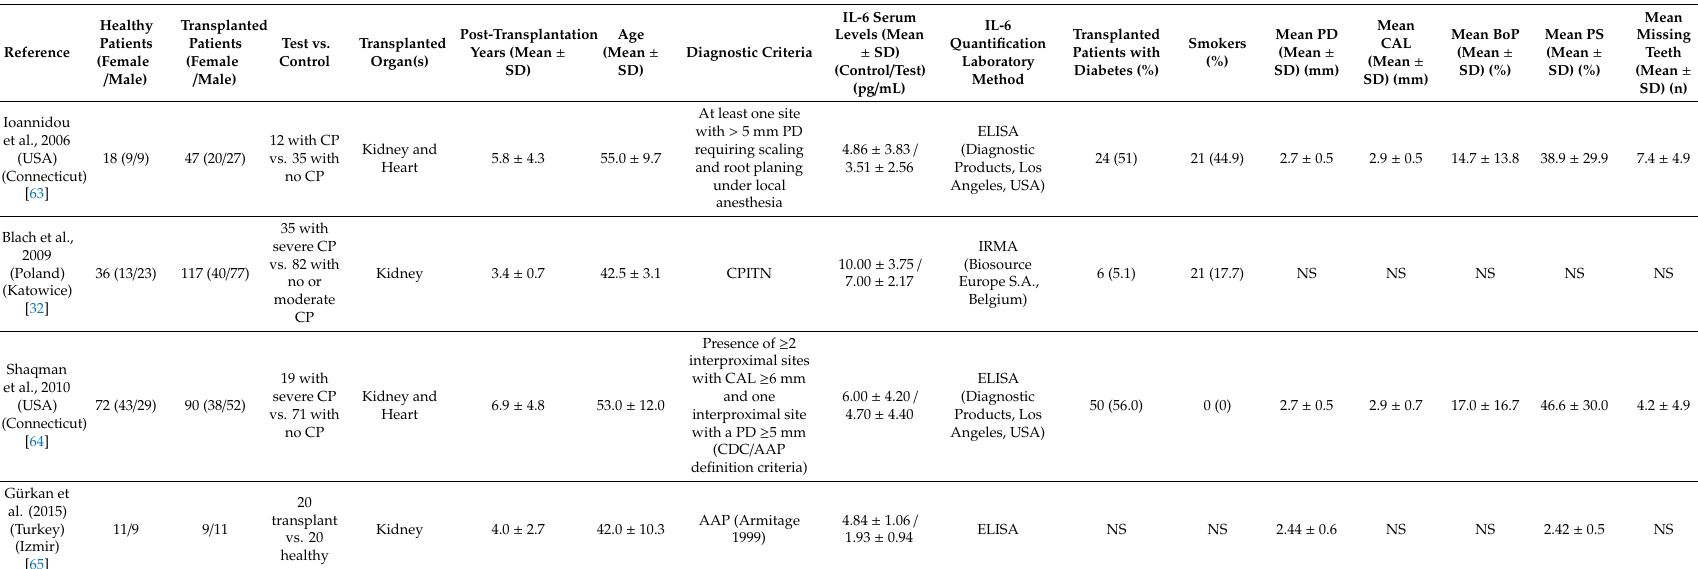
Table 1. Characteristics of the included